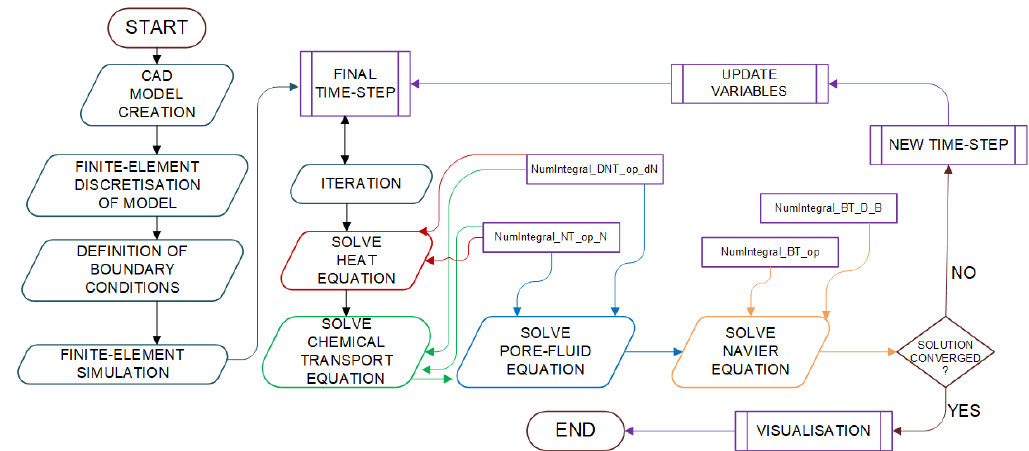
Figure 1. CSMP++ FEM modelling solution strategy developed in this